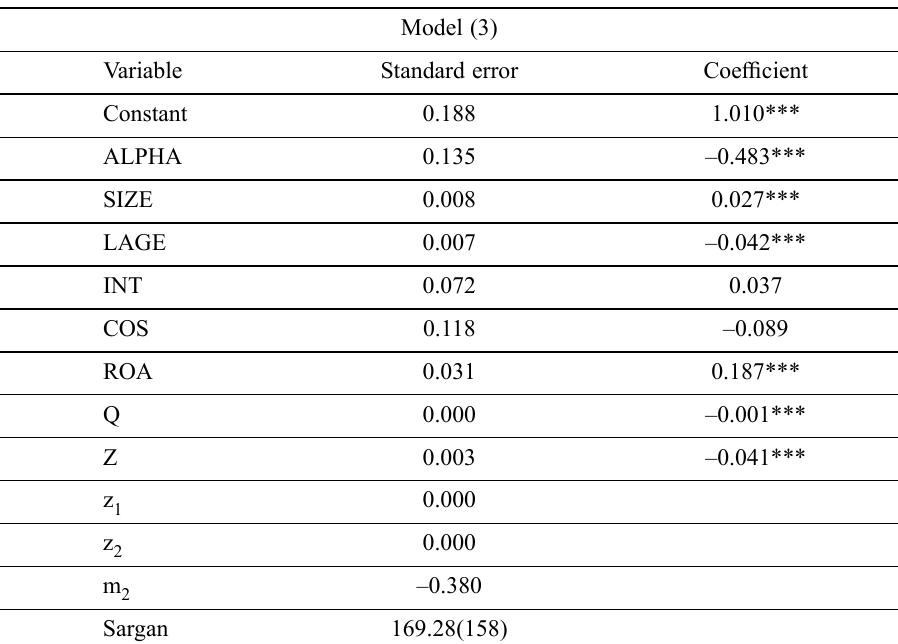
Table 3. GMM Panel Data Regression relative to the influence of the